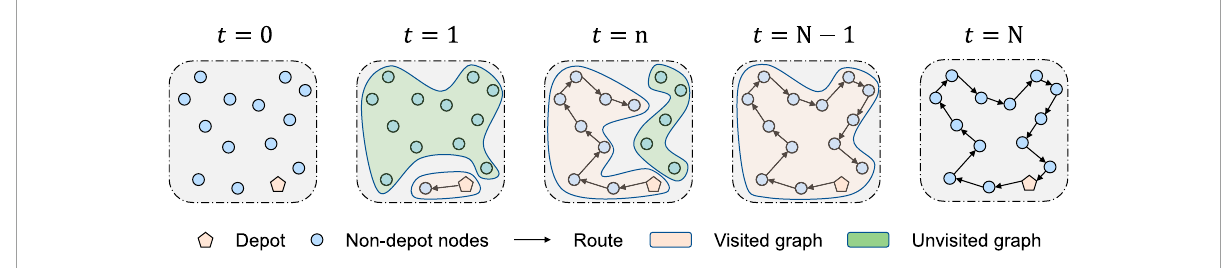
FIGURE 2 Constructive path searching process of our DT-DRL. After encoding, the node coordinates are projected to node embeddings, which remain unchanged throughout the entire decoding process. Afterwards, for each time step of decoding, one of the unvisited nodes will be selected. The resulting output is a sequence of nodes, representing the final route. In our approach, we seek to capture the dynamics of state transitions by means of modeling visited and unvisited graph. And the future traveling order depends merely on the current node, depot and unvisited